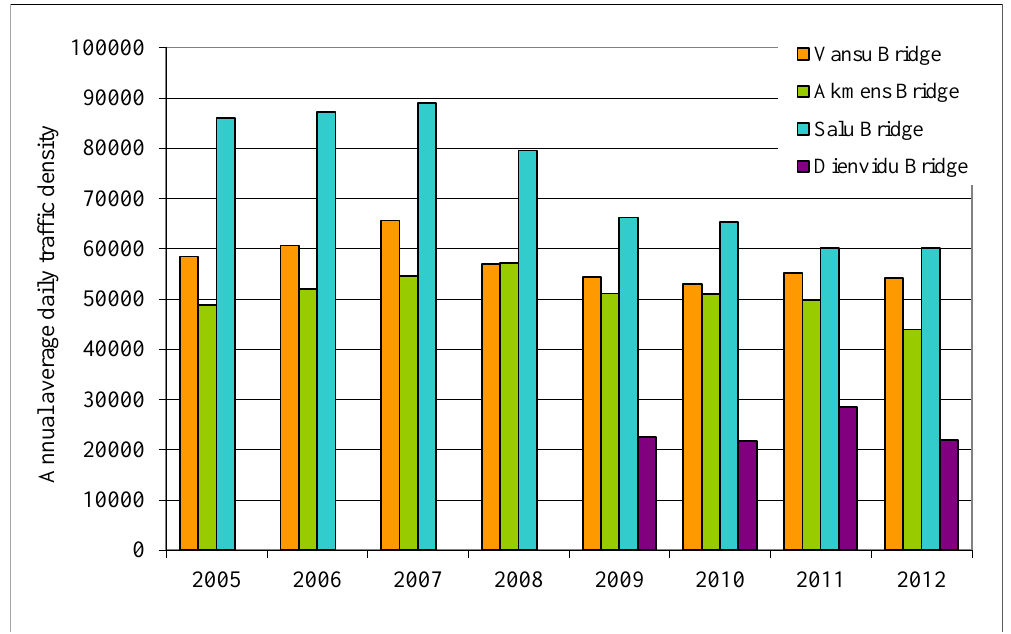
Fig. 4. Number of annual average daily traffic on bridges across the River Daugava in Riga (Dienvidu Bridge is the newest one and was opened in